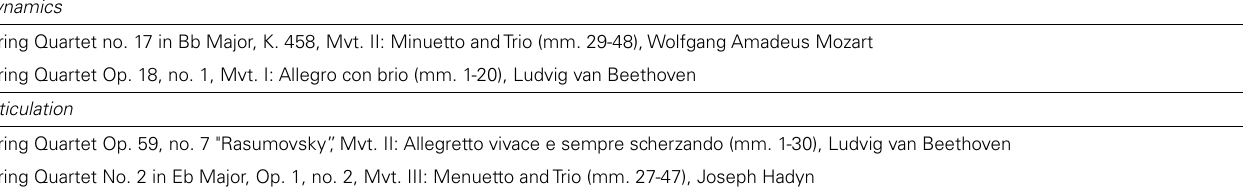
Table 1 | Performance excerpts.